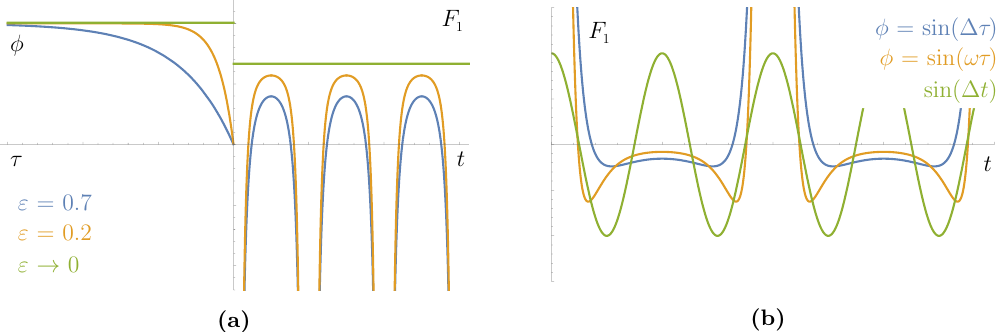
Figure 5. F 1 ( t ) for special sources. (a) we describe a limiting procedure to understand the constant φ configuration. One can see that these kind of sources generate periodic divergences as a response, but upon taking the limit the response stabilizes at a constant value. This is understood as the vacuum of a deformed theory as described in this one, as explained in more detail in the main text. One should regard the negative piece of the horizontal axis as τ and the positive piece as t . In (b) we perform a sanity check of our claims in the sense that we should not be able to select modes using single mode sources. We test this with two single mode sources with frequencies both corresponding to N modes of the system (blue) and for a generic frequency ω . In green we show the physical response one should get for the lowest physical mode. Neither source is able to produce a single mode